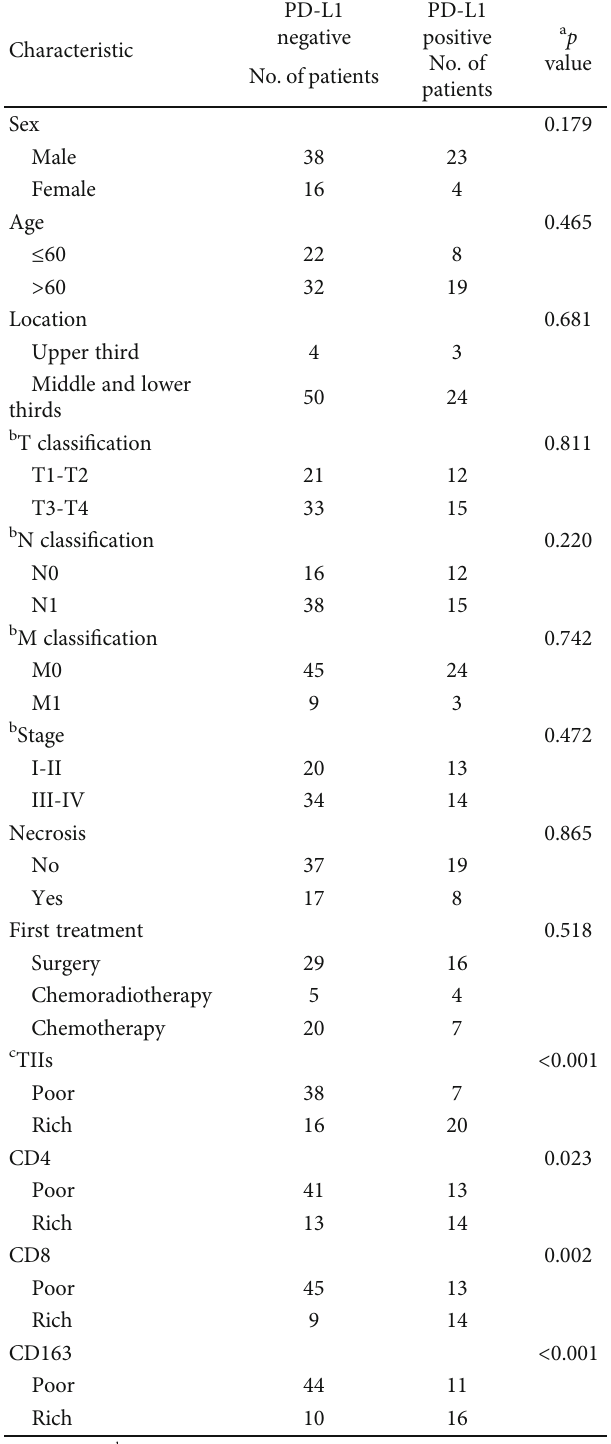
Table 1: Associations between PD-L1, clinicopathological characteristics, and other immune cells in